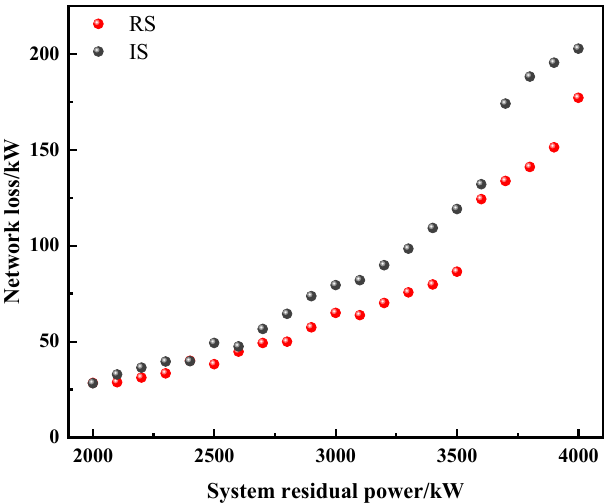
Figure 9. Comparison of the network loss under different residual power of the system. Table 1. Topology analysis of reconfiguration-load shedding